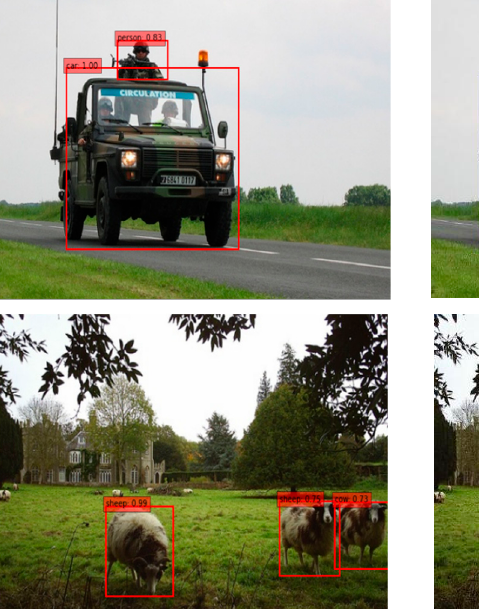
Table 1. Detection results using PASCAL VOC2007.